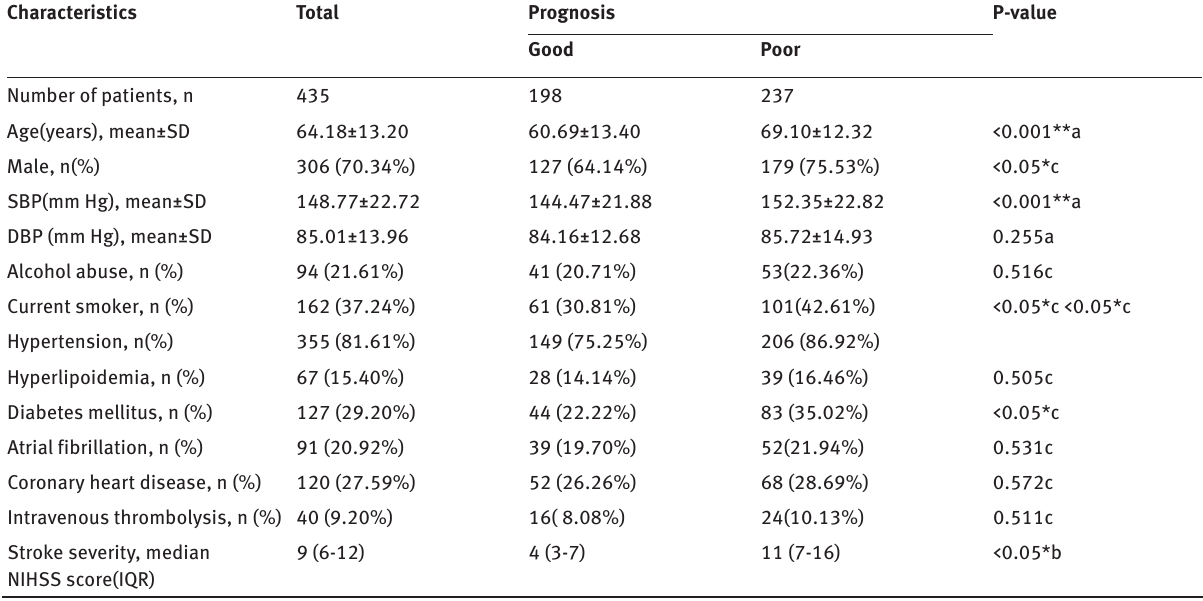
Table 1: Clinical characteristic of patients with acute ischemic stroke